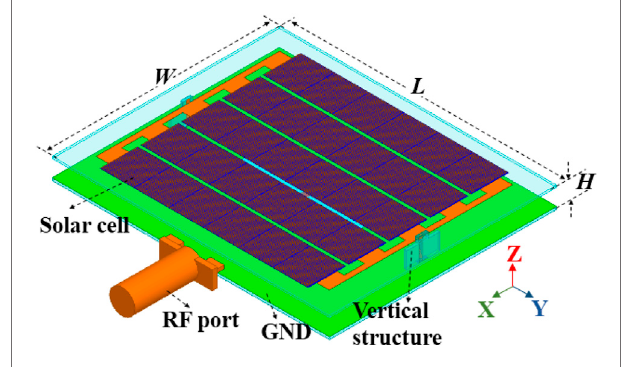
FIGURE 1 | The proposed dual-band solar cell antenna.